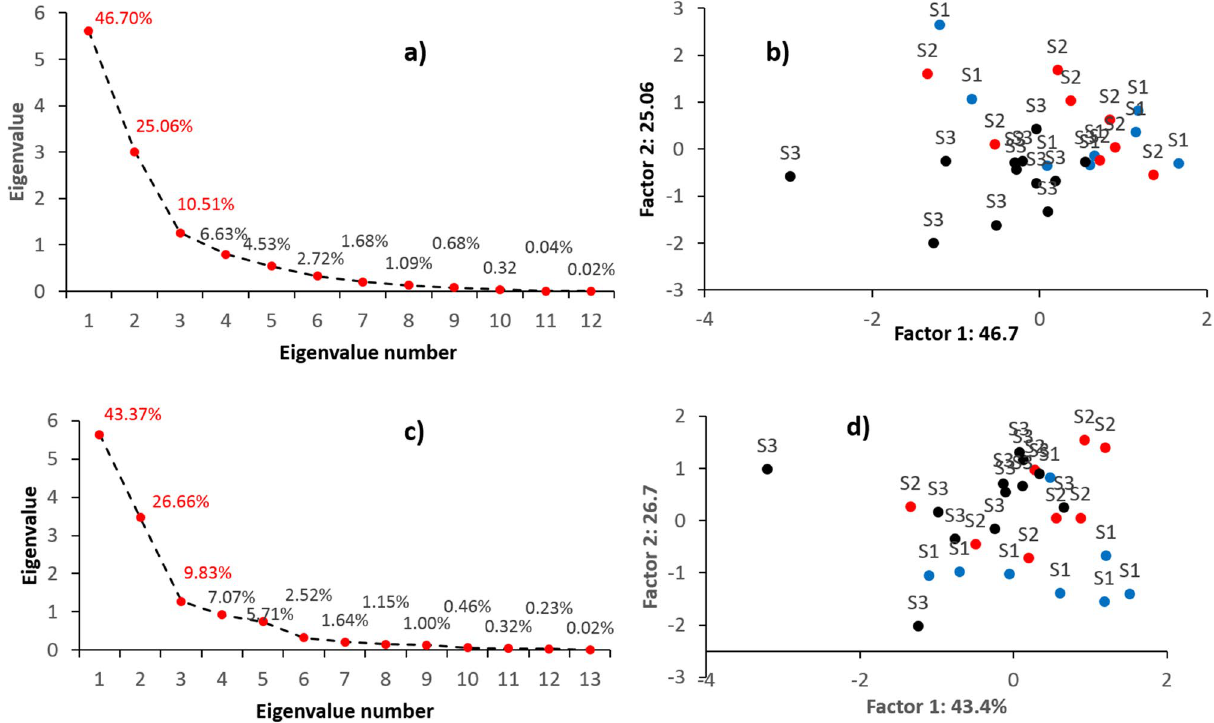
Figure 6. ( a ) Scree plot output from the PCA for the spatial sediment source discrimination based on geochemical tracers selected by TRT + KW, ( b ) projection of the cases on the principal component plane using PCA based on geochemical tracers selected by TRT + KW, ( c ) Scree plot output from the PCA for the spatial sediment source discrimination based on geochemical tracers selected by RTM + KW, and; ( d ) projection of the cases on the principal component plane using PCA based on geochemical tracers selected by RTM + KW. S1, S2 and S3 indicate samples collected from the spatial sources represented by the western, central and eastern sub- basins,